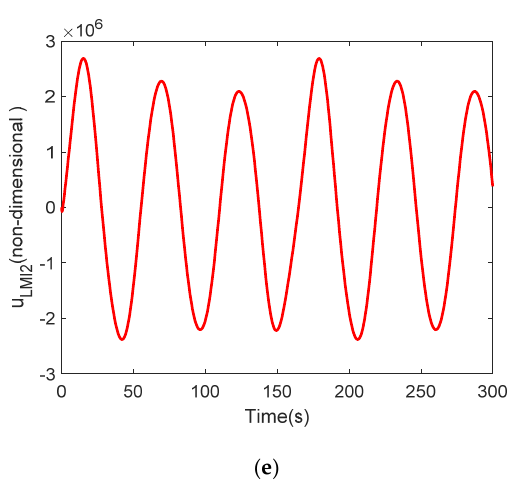
Figure 4. The controlled results and control performance under condition of w = 1 + sin ( 0.1 t ) / ( t + 1 ) using the second PFV valve: ( a ) the controlled bending ( Z ) / twist ( α ) displacements as well as pitch angle β ; ( b ) the robust performance parameters γ ; ( c ) the control input signal u I ; ( d ) the driving current signal I of PFV valve; ( e ) the tracking signal u LMI .